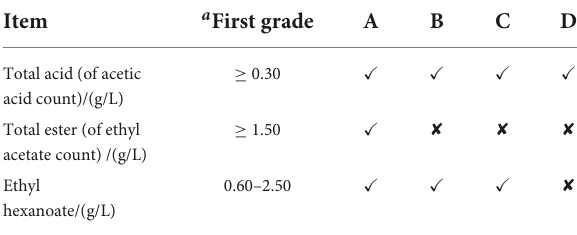
TABLE 3 Physicochemical indexes comparison of 4 grades of base SAB